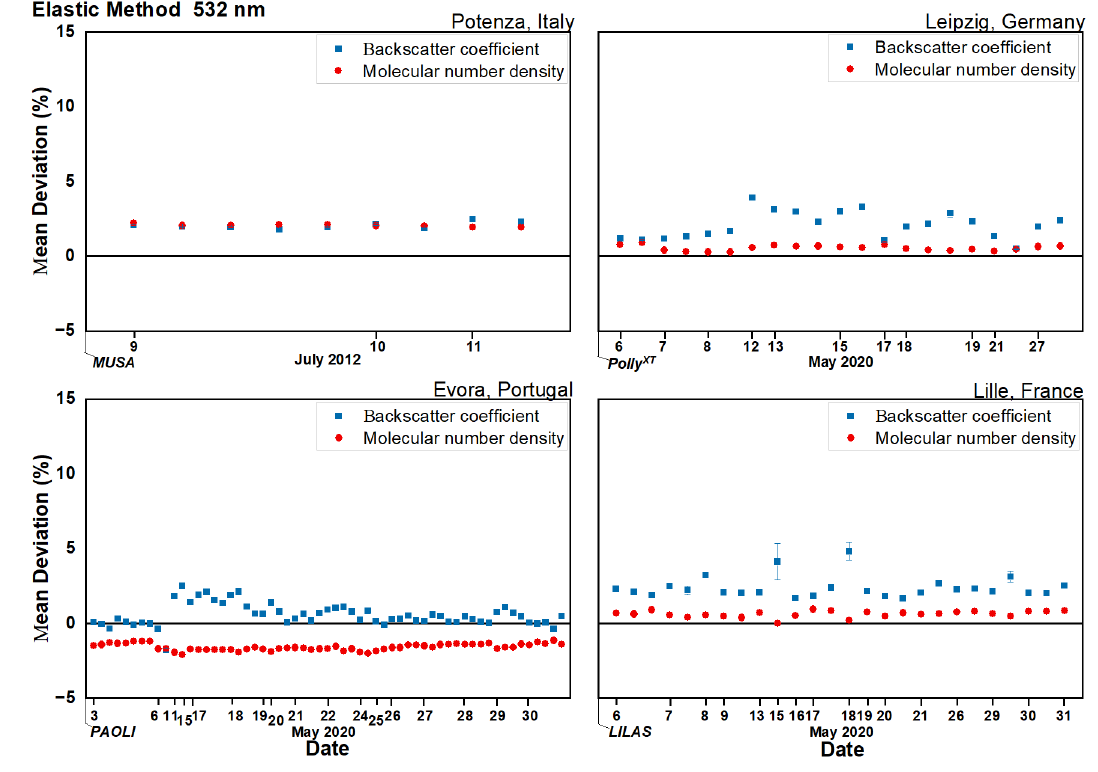
Figure 6. Same as Figure 5, but for 532 nm.